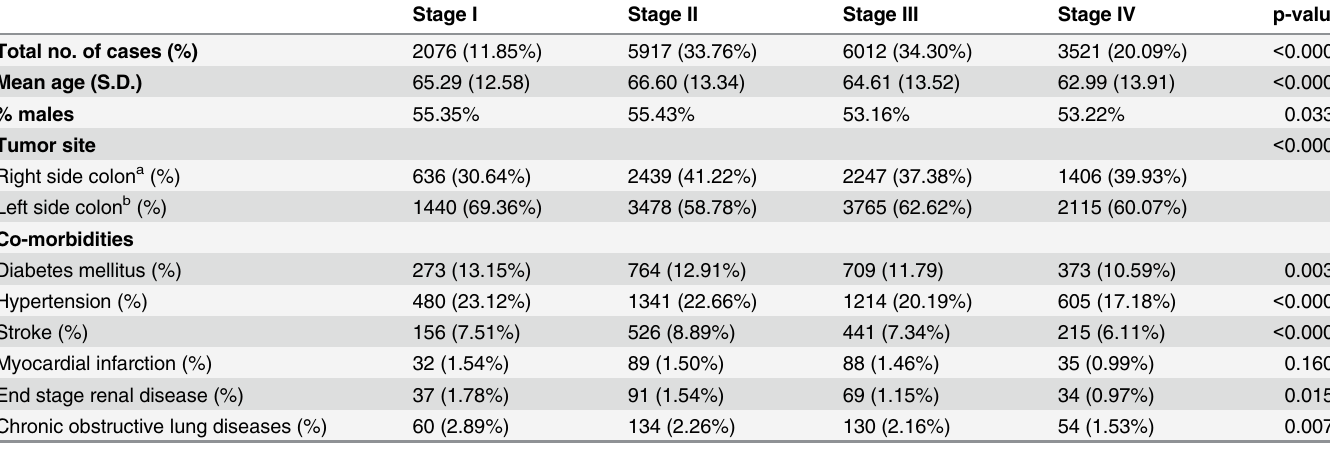
Table 1. Demographic and clinical characteristics of patients with colon